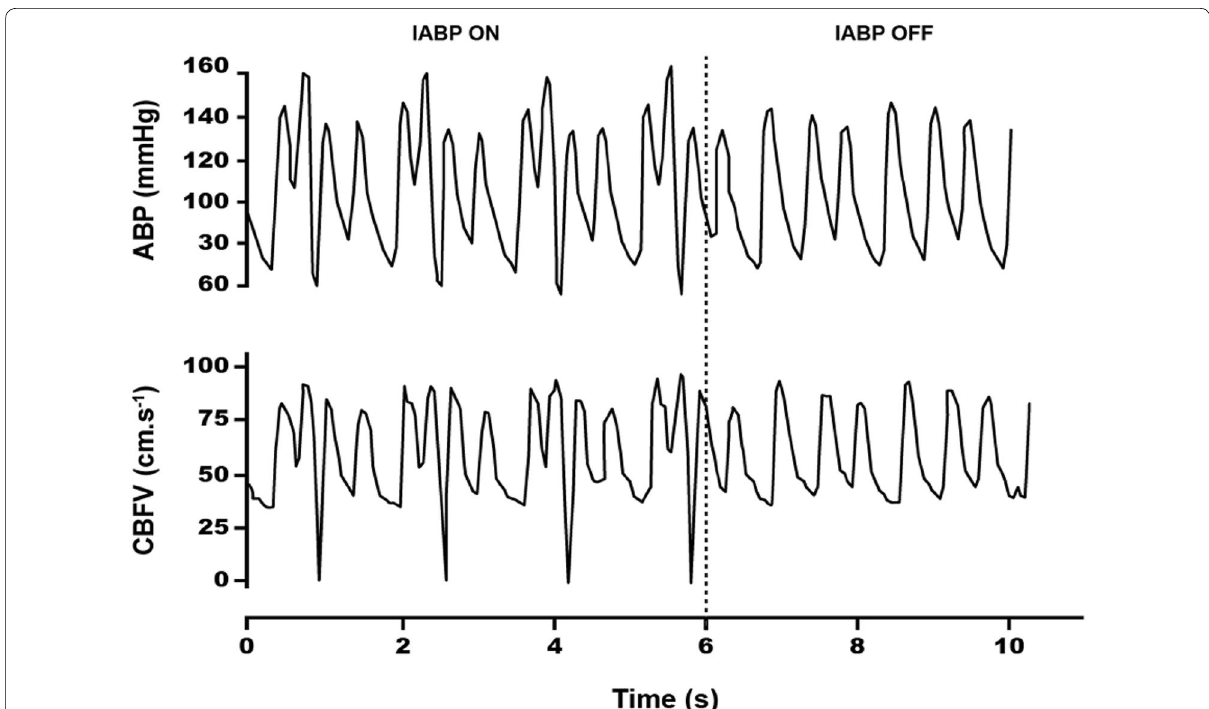
Fig. 2 Ten‑second continuous recording of blood pressure and cerebral blood flow velocity from 63‑year‑old male patient with IABP ratio 1:3, showing removal of the intra‑aortic balloon pump at t 6 s. This subject is representative of the frequent occurrence of cerebral blood flow velocity = diastolic values that are negative or near zero following deflation of the balloon (Reproduced with permission from Caldas et al. [22])